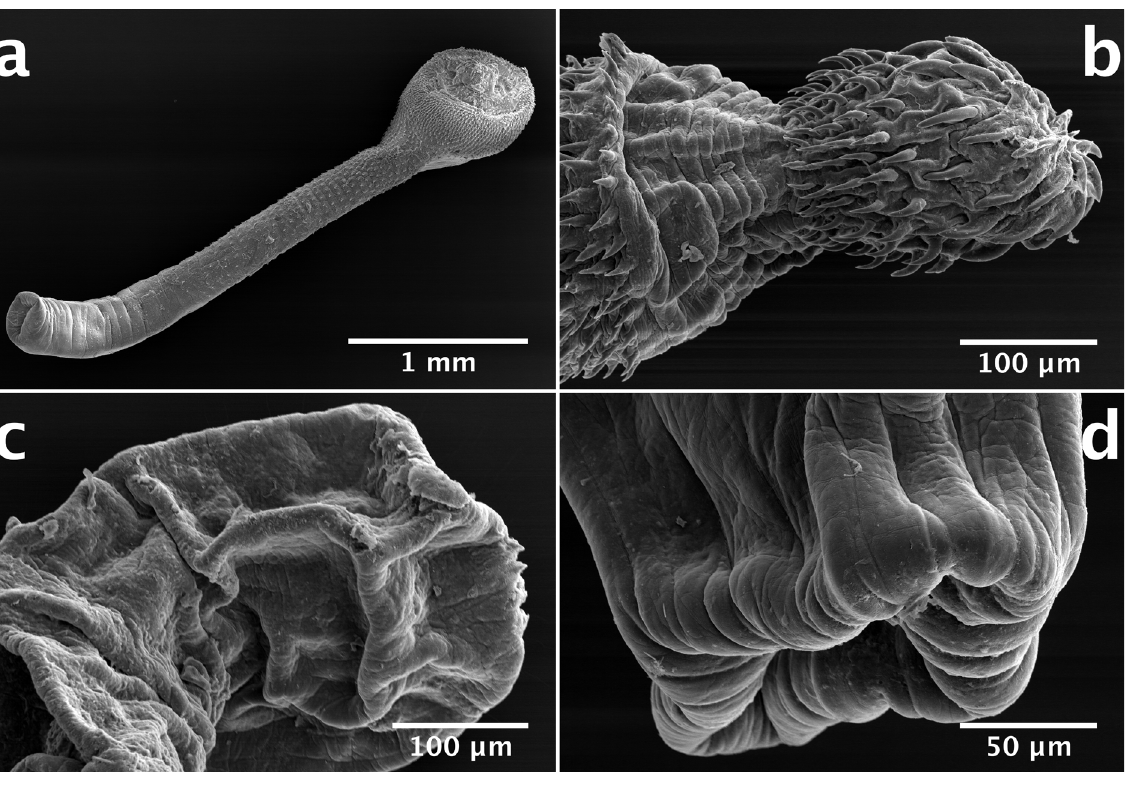
Fig. 3. SEM micrographs of Corynosma magdaleni from grey seals, Halichoerus grypus, in the Swedish Baltic Sea. a . ♀, entire worm, ventro-lateral view, from the Bothnian Bay, Norrbotten, Luleå. Ventral spination extends over more than half the length of the hind-trunk. b . Proboscis of a ♀ showing the spineless neck and the arrangement of the hooks. c . Posterior end of a ♂ showing the extended copulatory bursa. d . Posterior end of a ♀ in which the gonopore has been retracted into the gential